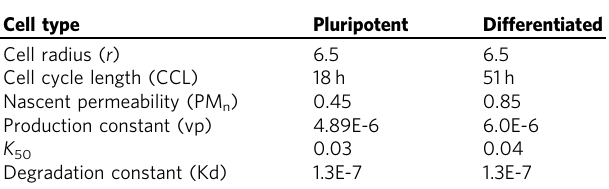
Table 2 Cell type speci fi c parameters used in ABM of intercellular communication Cell